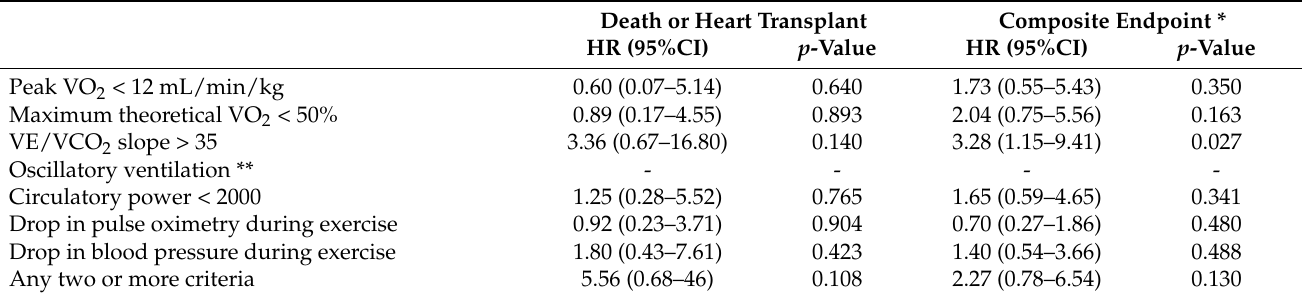
Table 2. Negative outcomes on exercise test and clinical events.